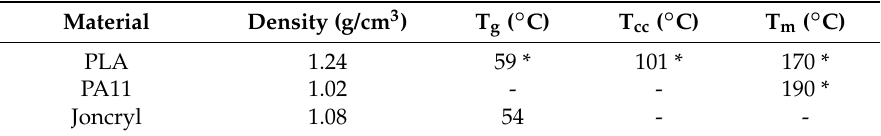
Figure 1. Chemical structure of Joncryl ADR ® -4368, and the general structure of the styrene-acrylic multifunctional oligomeric chain extenders. R 1 –R 5 are H, CH 3 , a higher alkyl group or combinations of them; R 6 is an alkyl group. x, y and z are between 1 and 20. Table 1. Characteristics of the raw